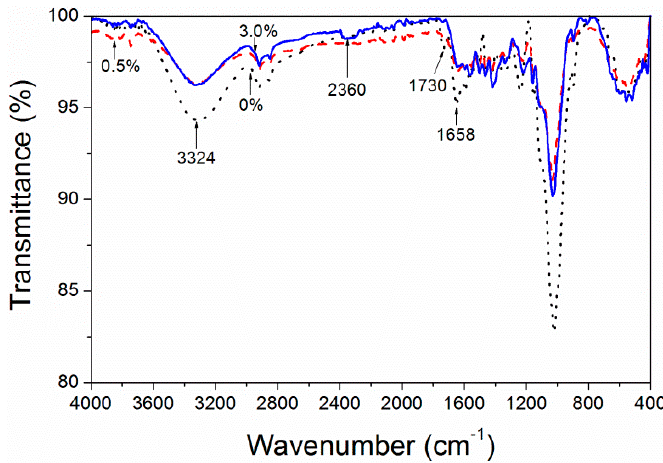
Figure 7. IR spectra of F. mandshurica veneer after dyeing with different concentrations of reactive blue.